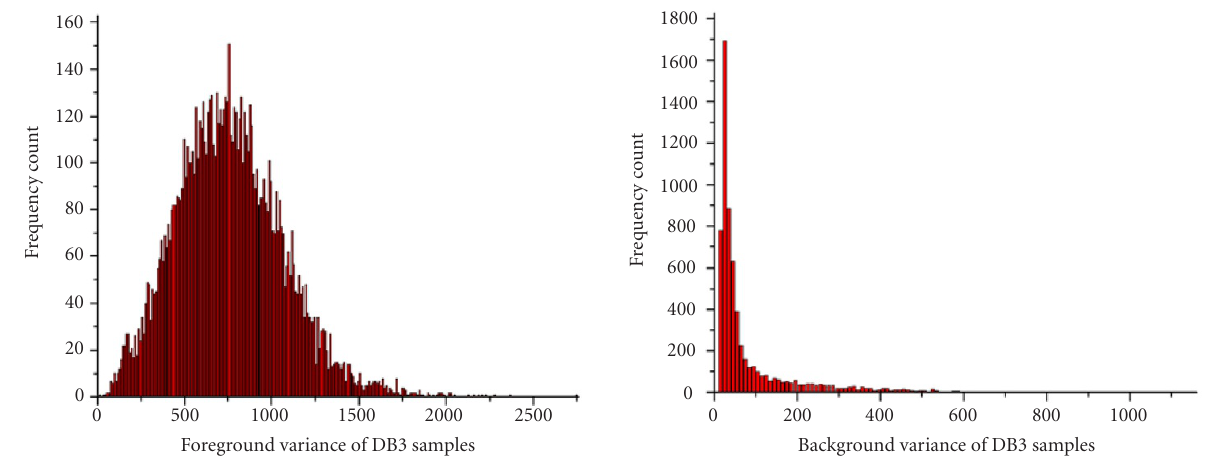
Figure 15: The block variance Var of the samples. The horizontal coordinate represents the value of the block variance while the vertical coordinate represents the frequency count of the